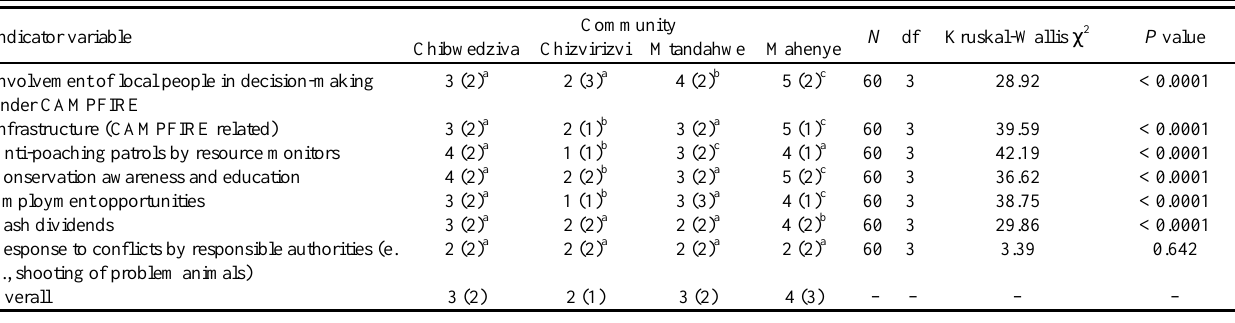
Table 3 . Indicators of success or performance of CAMPFIRE programs in four study communities adjacent to the northern Gonarezhou National Park, Zimbabwe, 2000–2010 (except for Chizvirizvi, which started in 2004 after being granted appropriate authority in 2003). Values are the mode, and range in parenthesis. Rating scale: 1 = strongly unfavorable, 2 = unfavorable; 3 = neutral; 4 = favorable; 5 = strongly favorable; N : sample size; df: degrees of freedom. Values with different superscript letters within rows differ significantly (Kruskal-Wallis test specific comparisons; P <